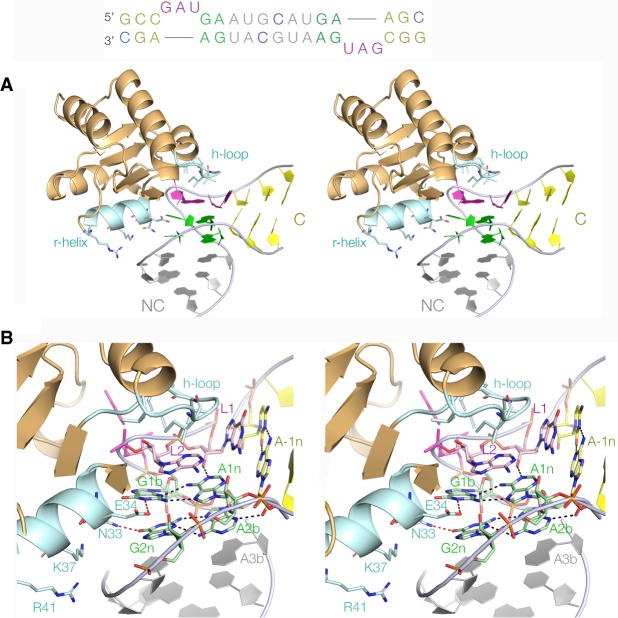
The structure of the A. fulgidus L7Ae–RNA complex. X-ray crystal structure of AfL7Ae bound to the k-turn of the l7ae 5′-UTR k-turn. The RNA (sequence shown at top) contains two copies of the potential k-turn related by twofold rotational symmetry. The two nucleotide changes were made to create full base-pairing at −3n and 5n; these are highlighted in blue. Our standard color-coding has been used for the k-turn, with the G:A base pairs green, the C and NC helices gray and yellow, respectively, and the loop magenta. This color scheme is also used in the structural images. The molecular graphics are shown as parallel-eye stereoscopic images. (A) The overall structure of the complex. The L7Ae protein is shown in cartoon form colored orange apart from the recognition helix and hydrophobic loop that are highlighted in cyan. Important amino acid side chains are shown in stick form. (B) The protein–RNA interactions in greater detail. The recognition helix (r-helix) is located in the widened major groove on the outer face of the k-turn, and the side chains of E34 and N33 are hydrogen bonded to the nucleobases of G1b and G2n, respectively. The hydrophobic loop (h-loop) sits over the L2, L1 region of the k-turn.